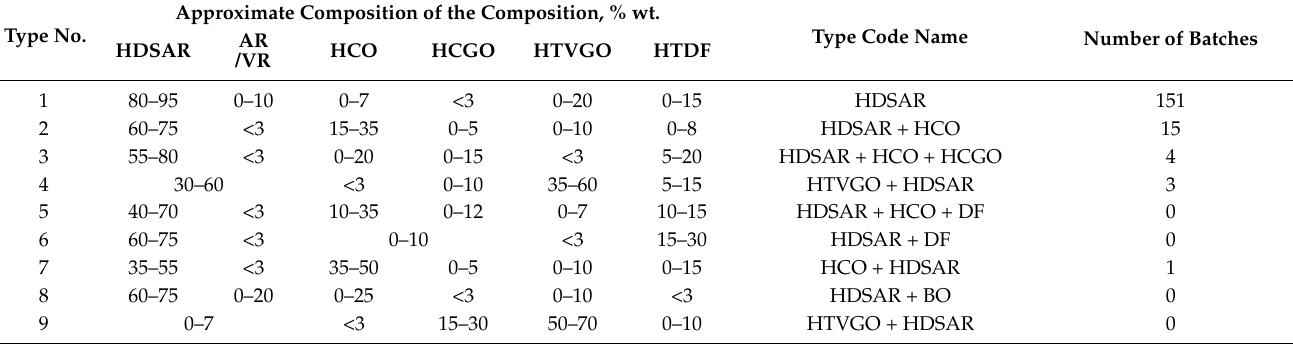
Table 15. Distribution of shipments of RME 180 from ports of the Middle East by type [95].